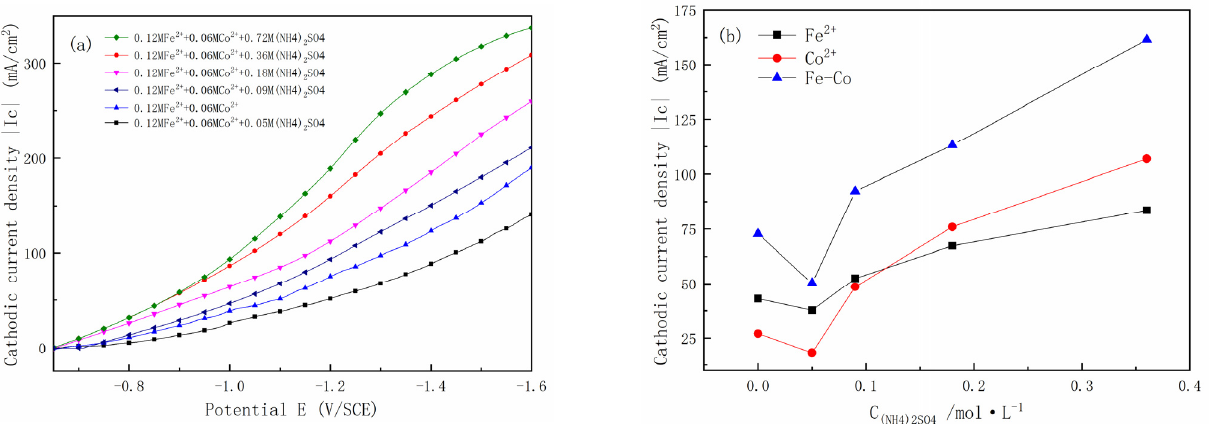
Figure 8. ( a ) Cathodic polarization curves measured in solutions with di ff erent (NH 4 ) 2 SO 4 concen- trations; ( b ) the corresponding cathodic current density |Ic| at a potential of − 1.2 V.